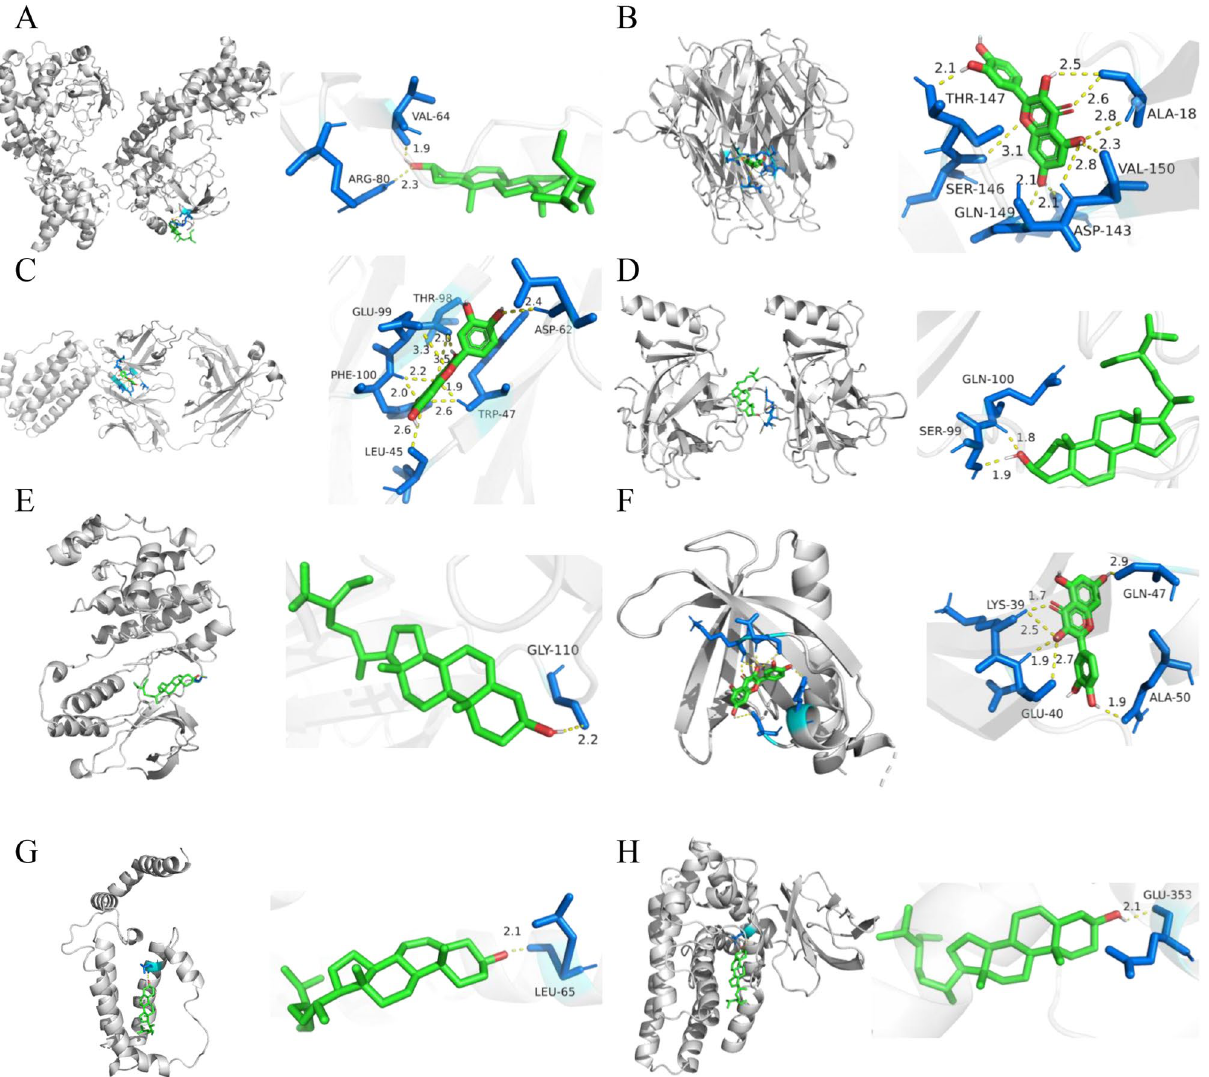
Figure 6. Docking complexes of ligand and receptor proteins and their binding residues are shown using PYMOL software. ( A ) RELA and β-sitosterol. ( B ) TNF and quercetin. ( C ) IL6 and quercetin. ( D ) TP53 and stigmasterol. ( E ) MAPK1 and β-sitosterol. ( F ) AKT1 and quercetin. ( G ) IL10 and β-sitosterol. ( H ) ESR1 and